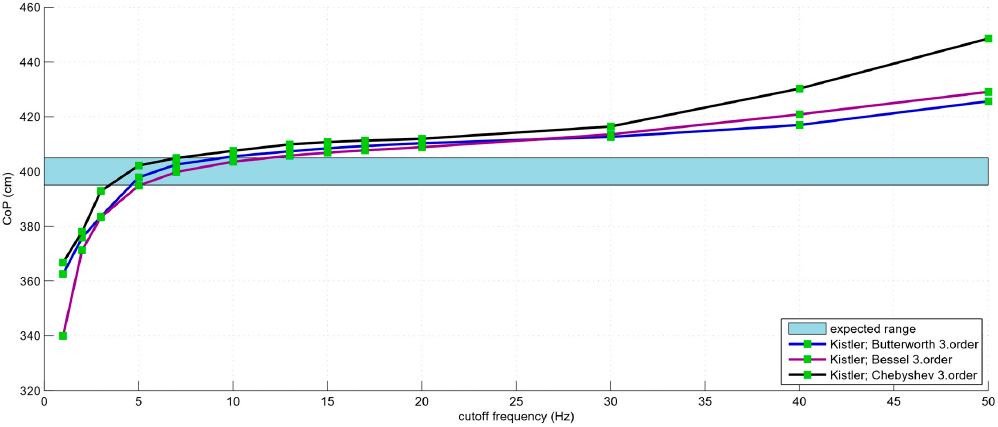
Figure 6. Representation of the characteristic curves of third-order Bessel, Butterworth, and Chebyshev filters.